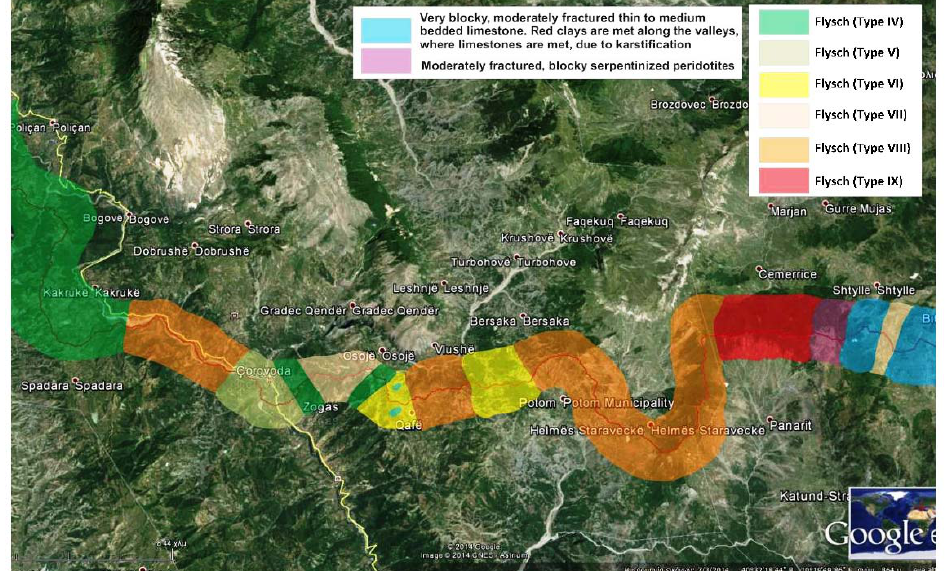
Figure 8. Geological strength index (GSI) chart for heterogeneous and structurally complex rock masses, such as flysch used for rock mass quality classification. N/A: Not applicable cases in nature.